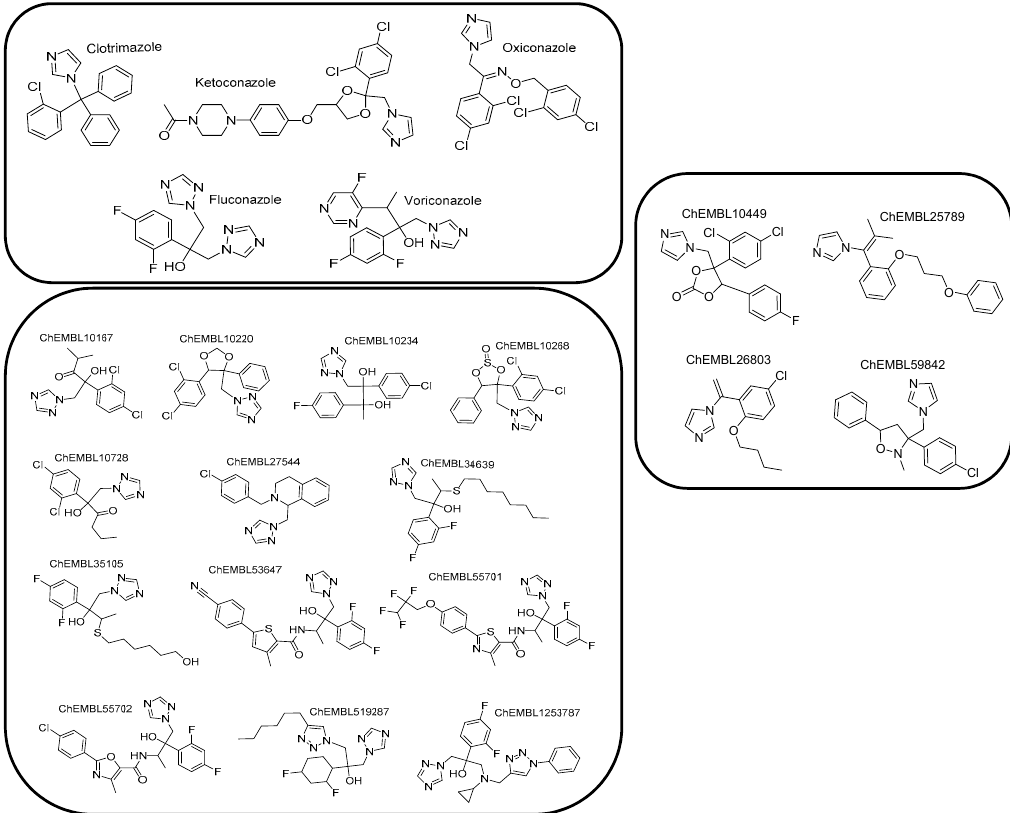
Figure 2. Chemical structures comprising the training set.